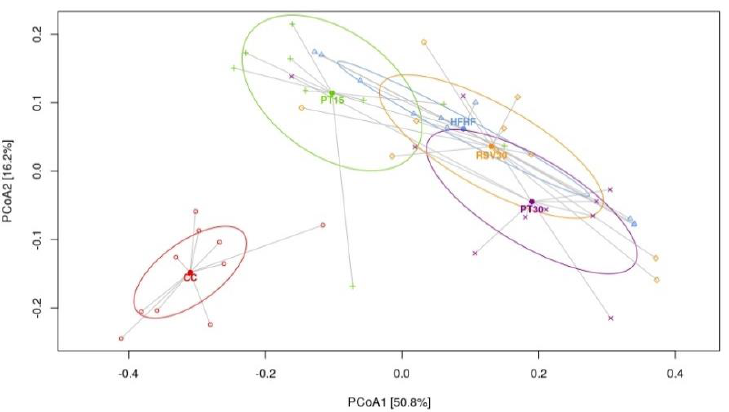
Figure 3. Microbial diversity of the studied groups according to Chao1, Shannon and Simpson. *** p < 0.001. Statistical analysis performed using Kruskal–Wallis test and Wilcoxon test.